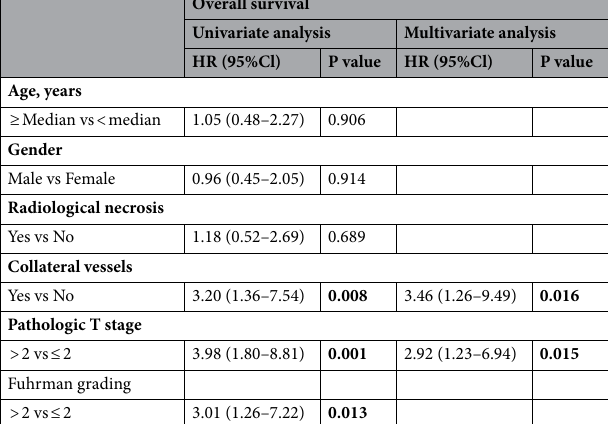
Overall survival Univariate analysis Multivariate analysis HR